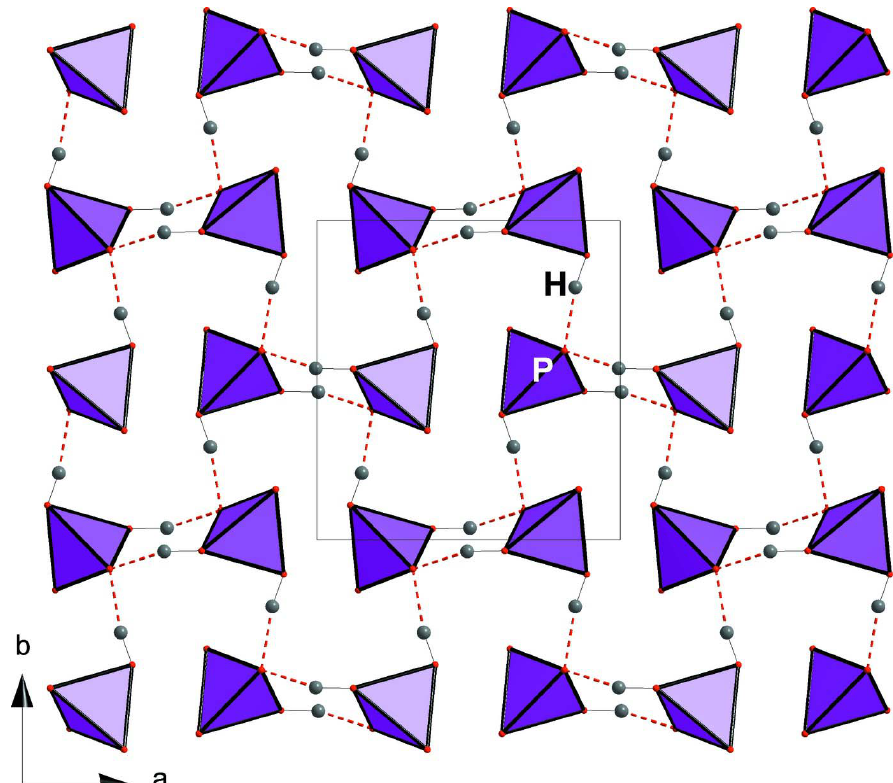
Figure 2 Projection of (H